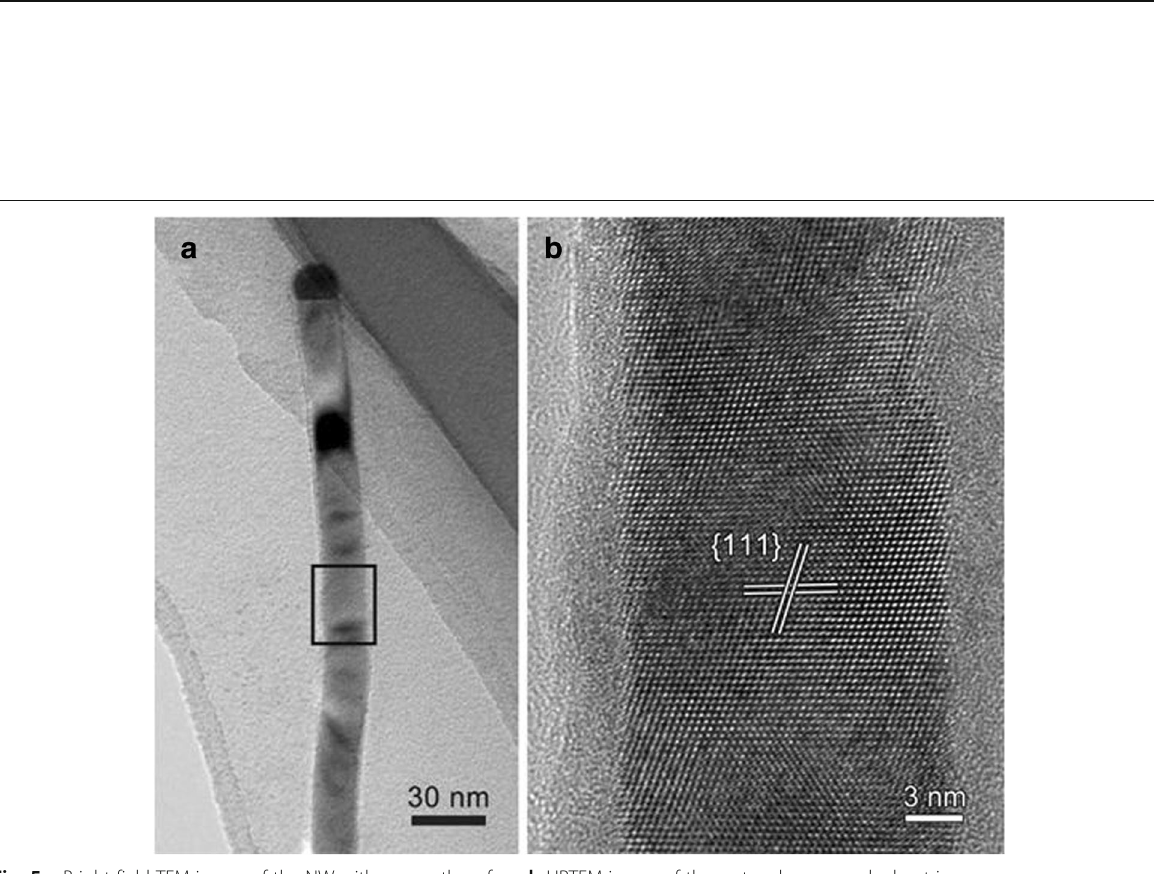
Fig. 4 a Bright-field TEM image of the zigzag morphology. b HRTEM image of the rectangle area marked in a , and the insets of (i) – (iii) are the SAED patterns corresponding to the A region, A/B boundary region, and B region, respectively